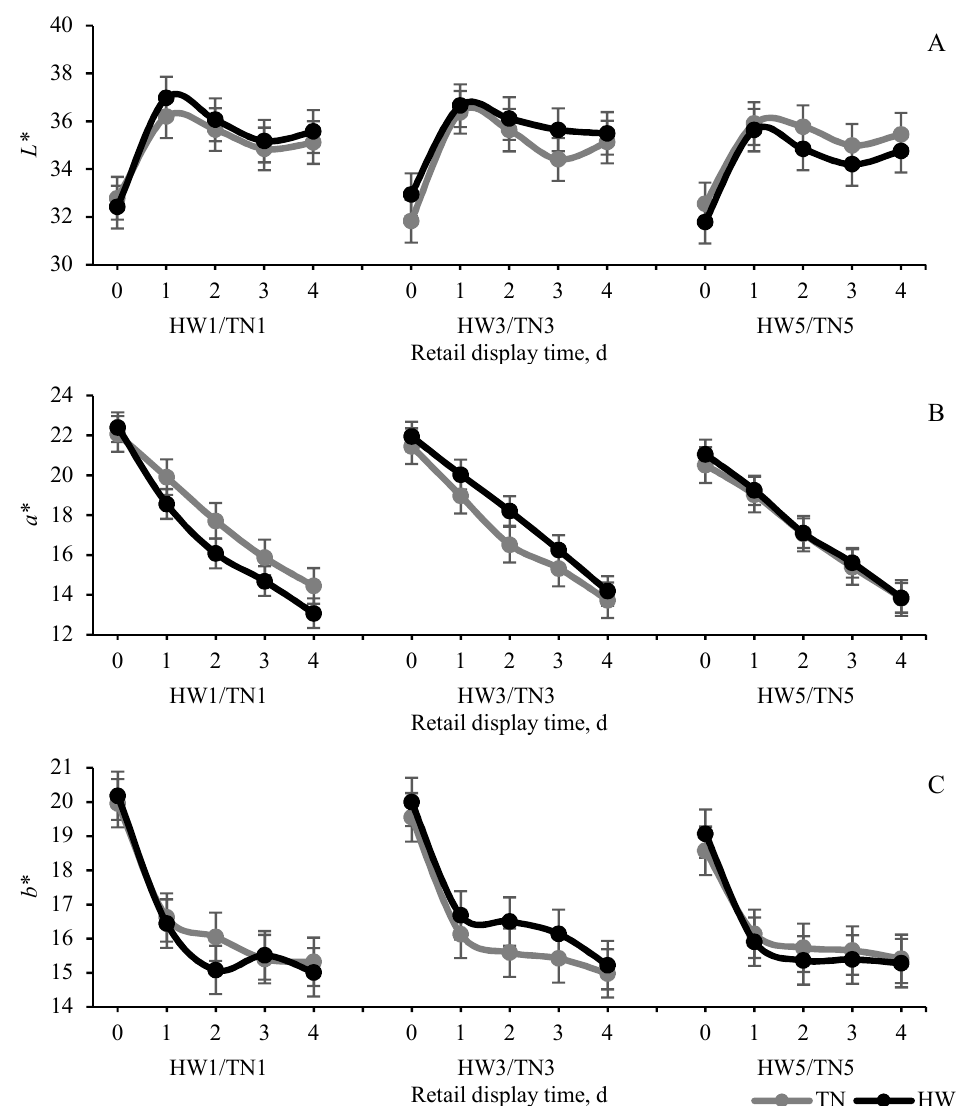
Figure 5. The effect temperature (thermoneutral, TN vs. heatwaves, HW) and heat exposure duration (1 vs. 3 vs. 5 days) on lightness ( L* ), redness ( a* ), yellowness ( b* ) of semimembranosus muscle in 4 days’ overwrap retail display: values are mean ± SED; HW/TN1–5 = 1 to 5 days HW/TN groups; temp. = temperature (n = 12 per group); lightness ( L* ; temp. p = 0.73; day p = 0.64; temp. × day p = 0.42); redness ( a* ; temp. p = 0.95; day p = 0.51; temp. × day p = 0.054); yellowness ( b* : temp. p = 0.62; day p = 0.39; temp. × day p = 0.35). ( A ) lightness ( L *); ( B ) redness ( a* ); ( C ) yellowness ( b* ). Table 1. The effect of temperature (thermoneutral, TN vs. heatwaves, HW) and heat exposure duration (1 vs. 3 vs. 5 days) on drip, purge and cooking loss of longissimus thoracis et lumborum (LTL) and semimembranosus (SM) muscle in 4 days’ overwrap retail display in lambs ( n = 12 per group).